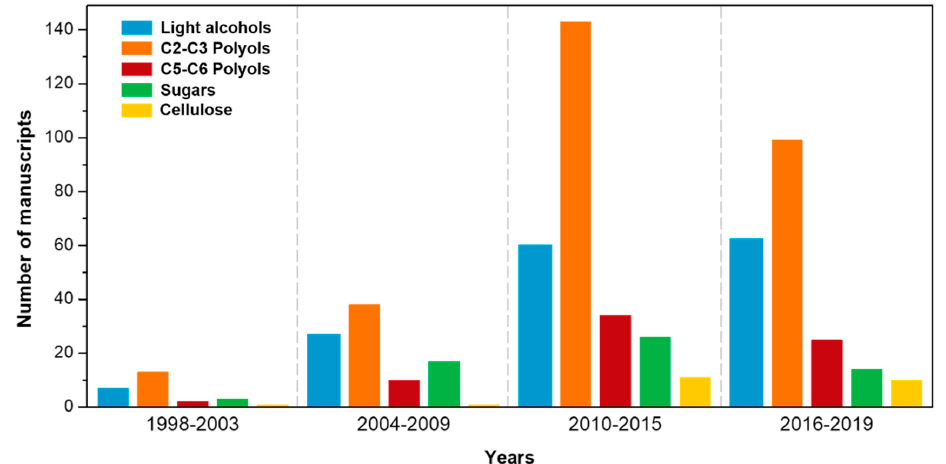
Figure 2. Trend of the peer review manuscripts contain “X aqueous phase reforming” (with X =